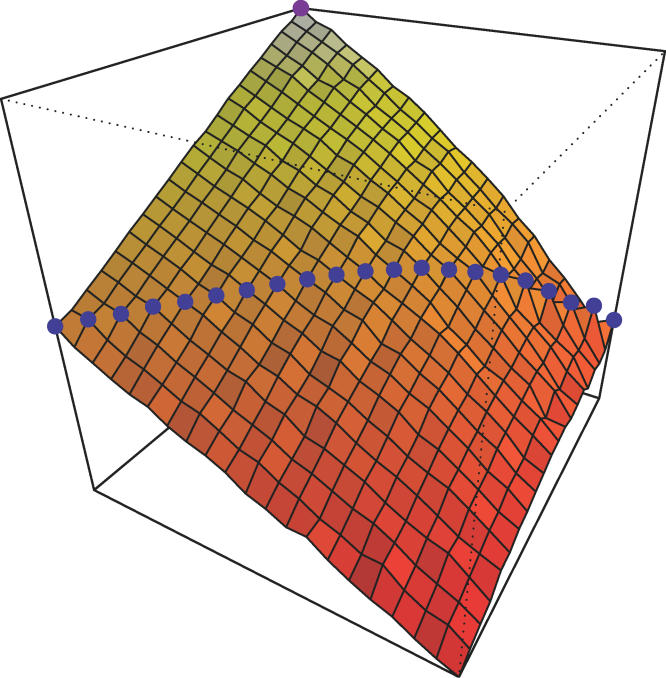
Phenotypic plasticity can increase the steepness of the fitness surface, which magni? es competitive differences and thereby acts as a barrier to species invasion.